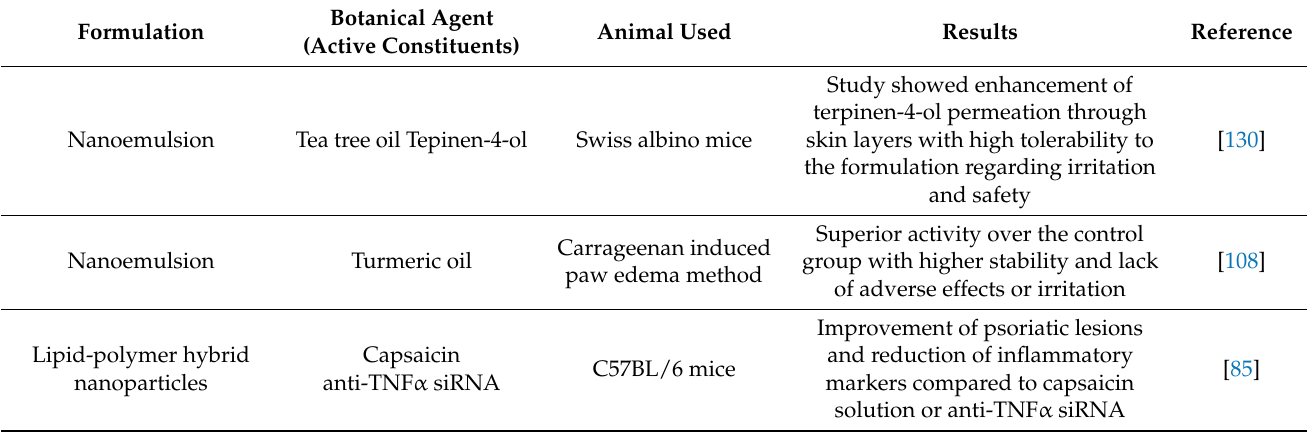
Table 1. Effective nano-based delivery systems encapsulating botanical agents for the treatment of psoriasis assessed via in vivo